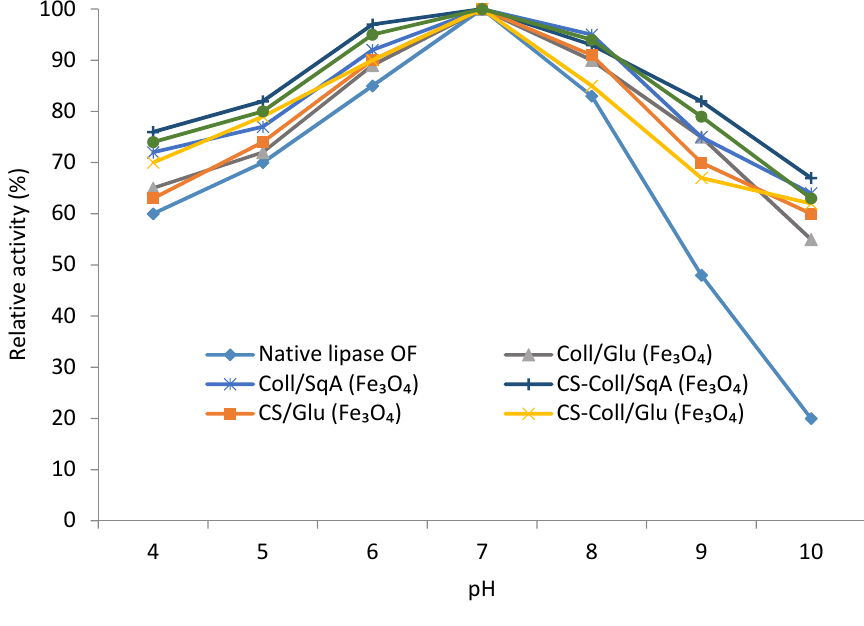
Figure 6. Effect of pH value on lipase